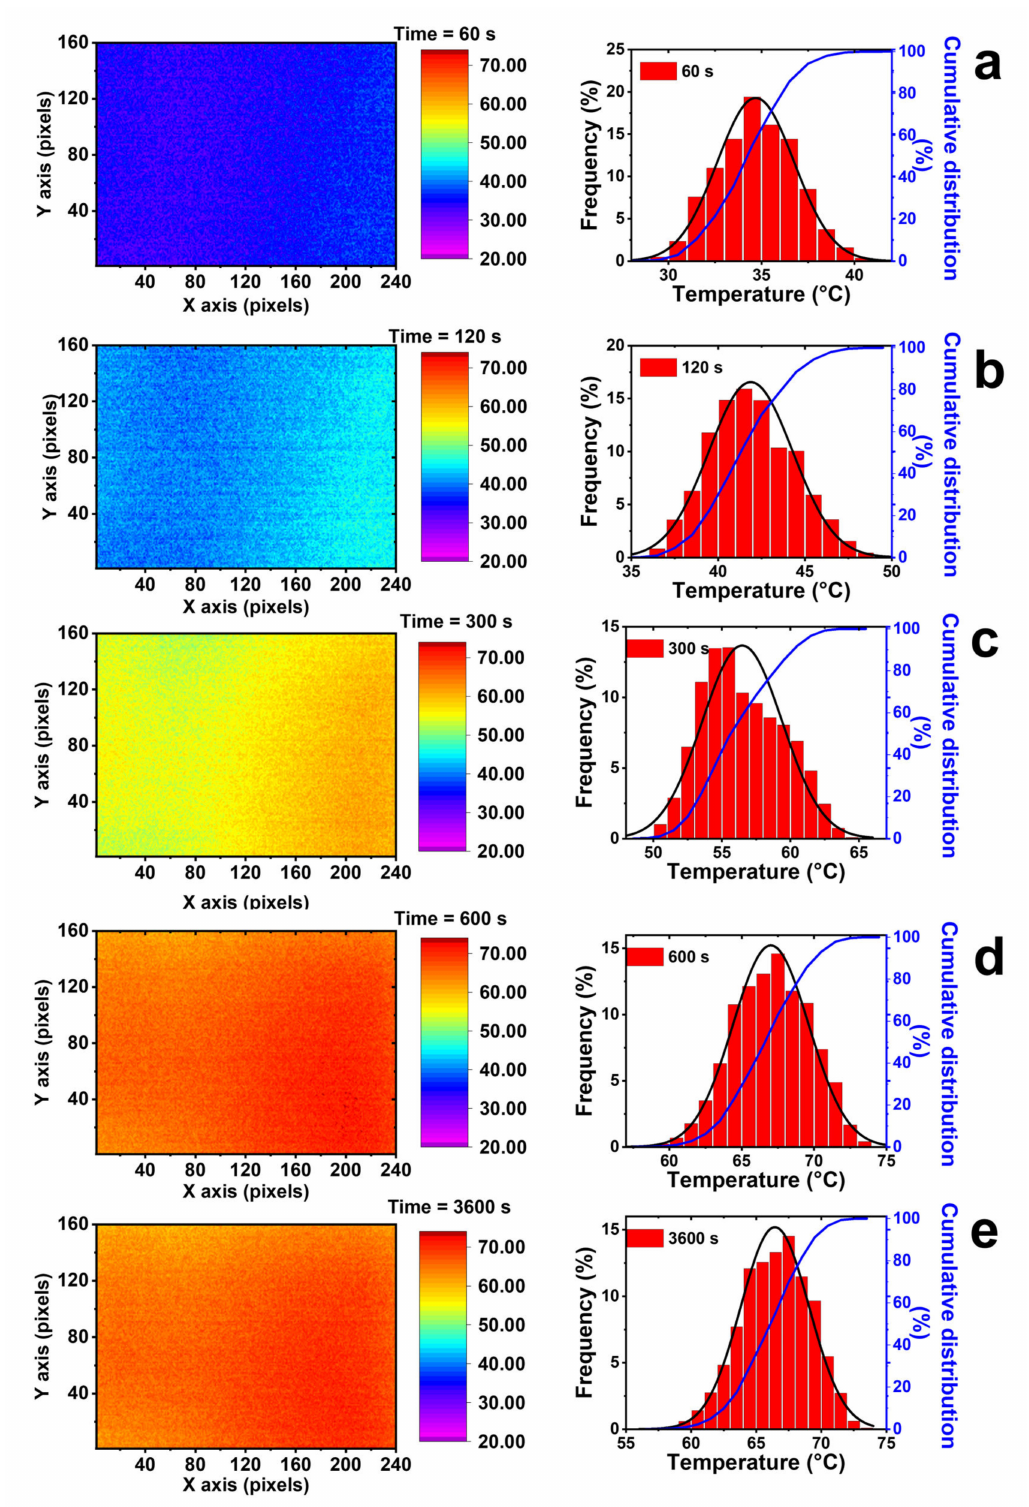
Figure 10. Thermal images in the central region and relating distribution temperatures of the 3% formulation, for an applied voltage of 90 V, at different heating times: ( a ) 60 s, ( b ) 120s, ( c ) 300 s, ( d ) 600s, and ( e ) 3600 s. In the temperature distribution images, the solid black lines are fitted by normal distribution curves and the solid blue lines are the cumulative distribution